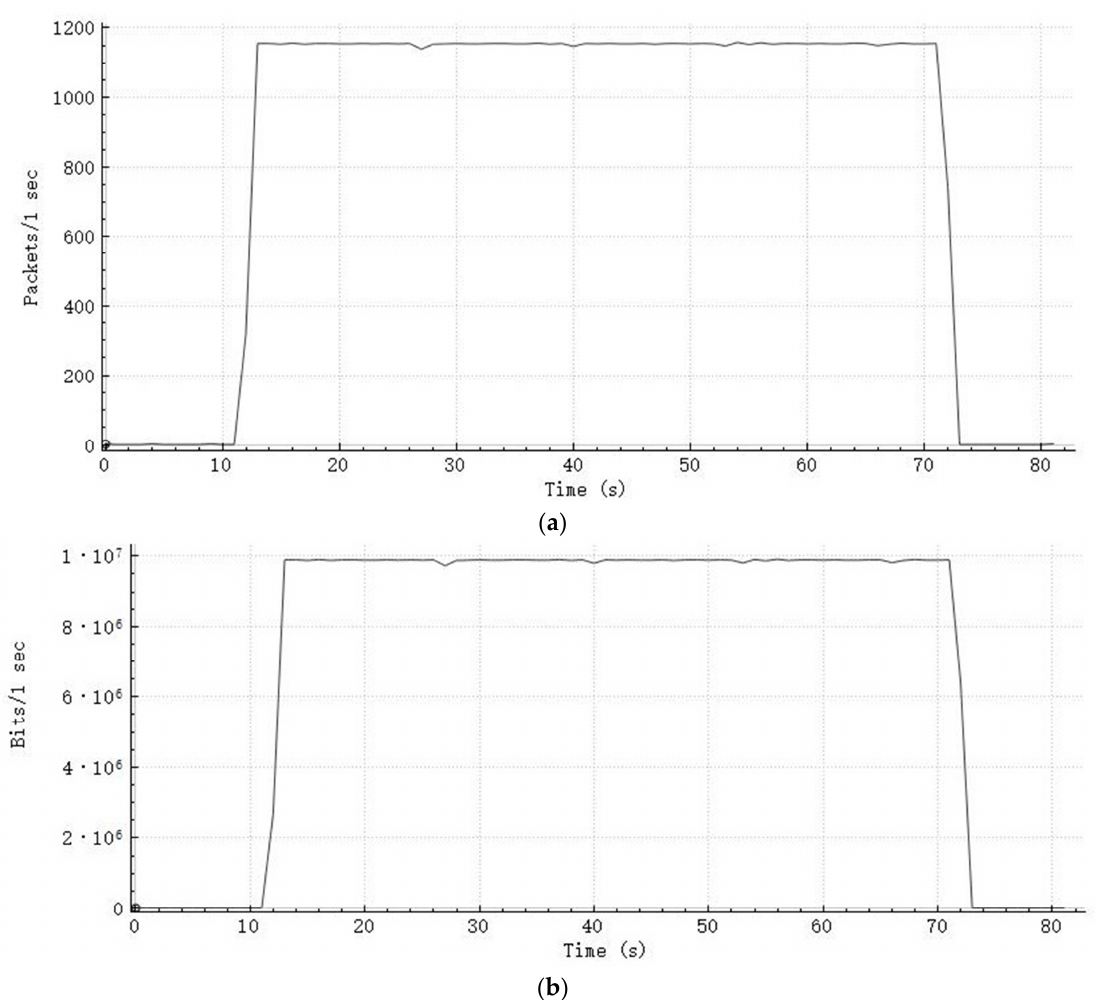
Figure 8. Monitored data transmission condition: ( a ) received packet count, ( b ) received bit count.